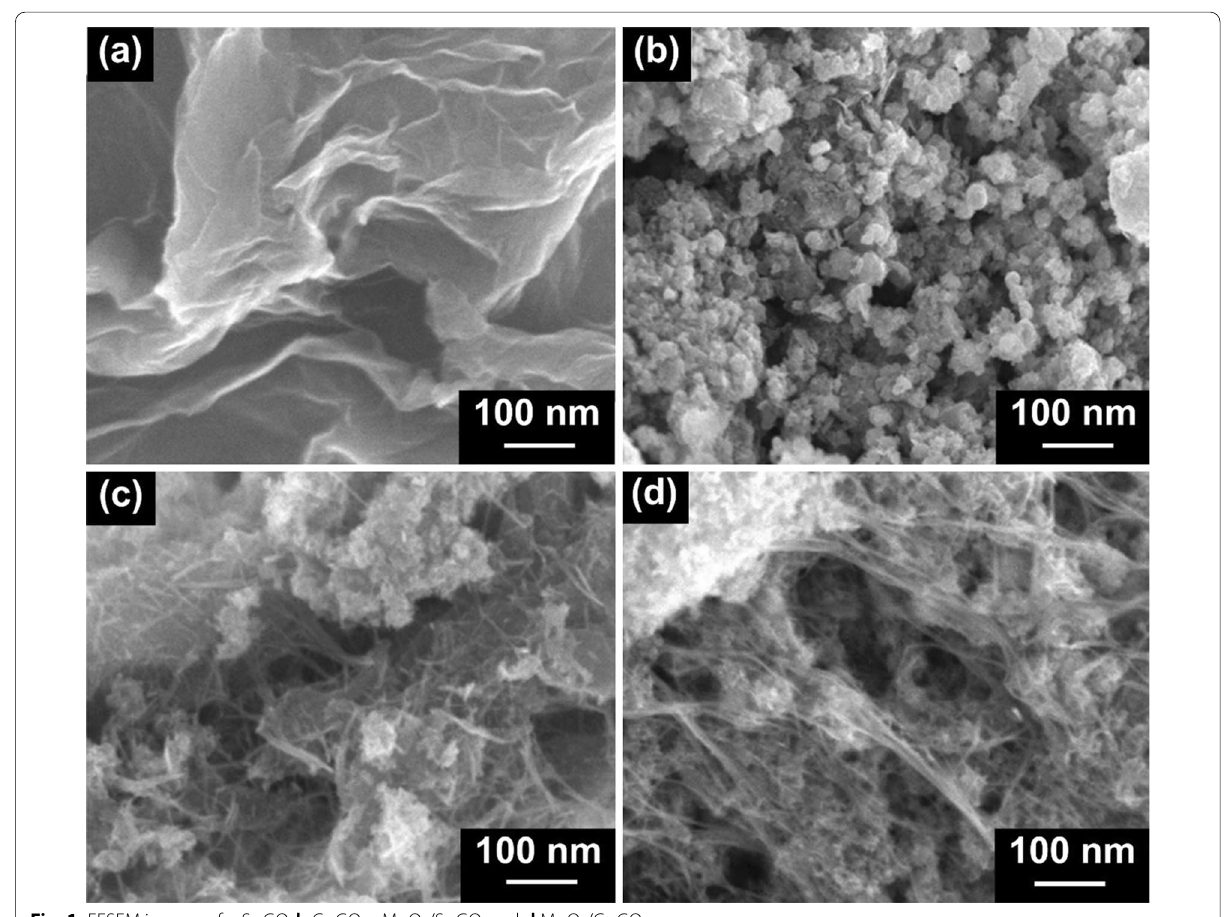
Fig. 1 FESEM images of a S-rGO, b C-rGO, c MnO x /S-rGO, and d MnO x